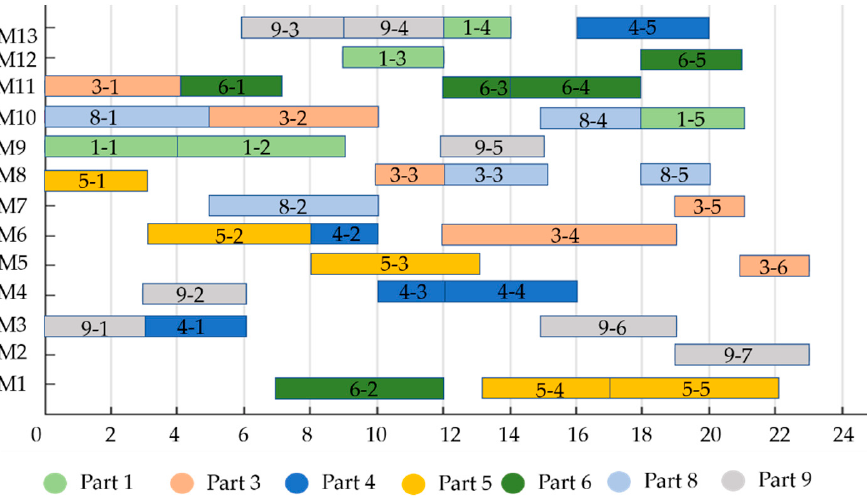
Figure 9. Comparison of six algorithms convergence curves for large-scale TPS8.